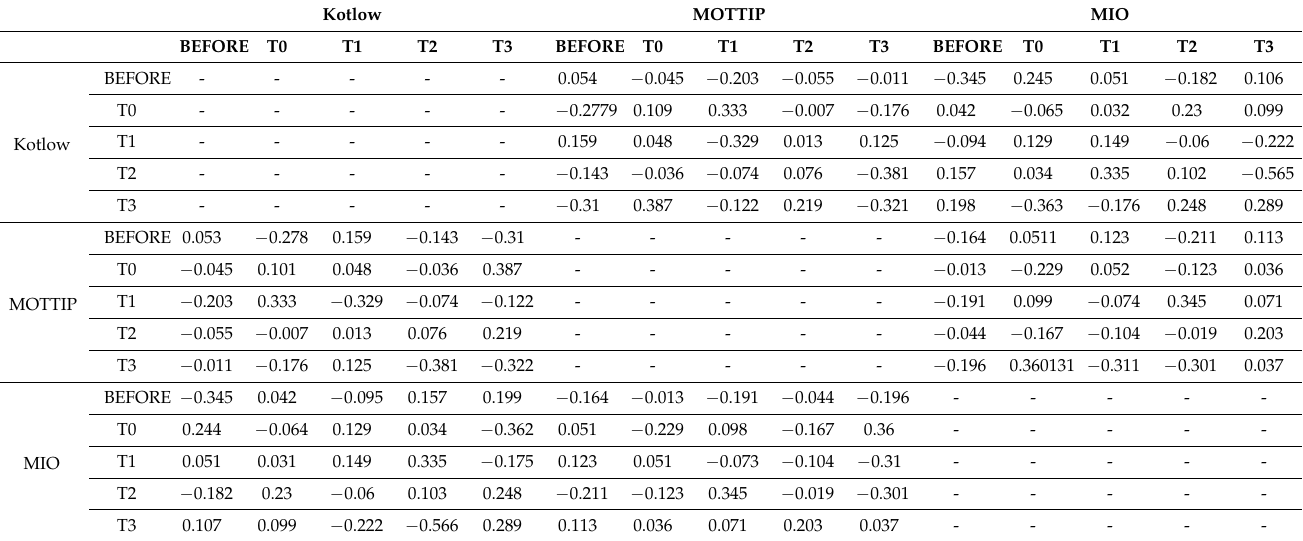
Table 2. Pearson’s coefficient (r) table of Kotlow’s free-tongue measurement, MOTTIP and